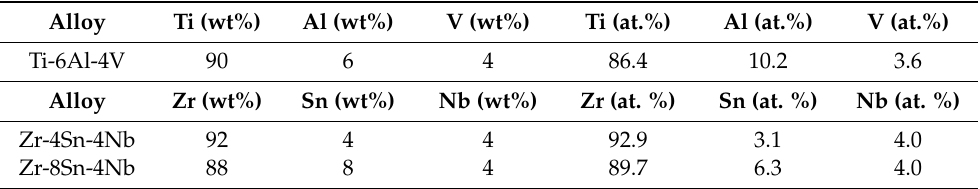
Table 1. Comparison of wt% and at.% of Ti-6Al-4V and proposed Zr-Sn-Nb alloys.